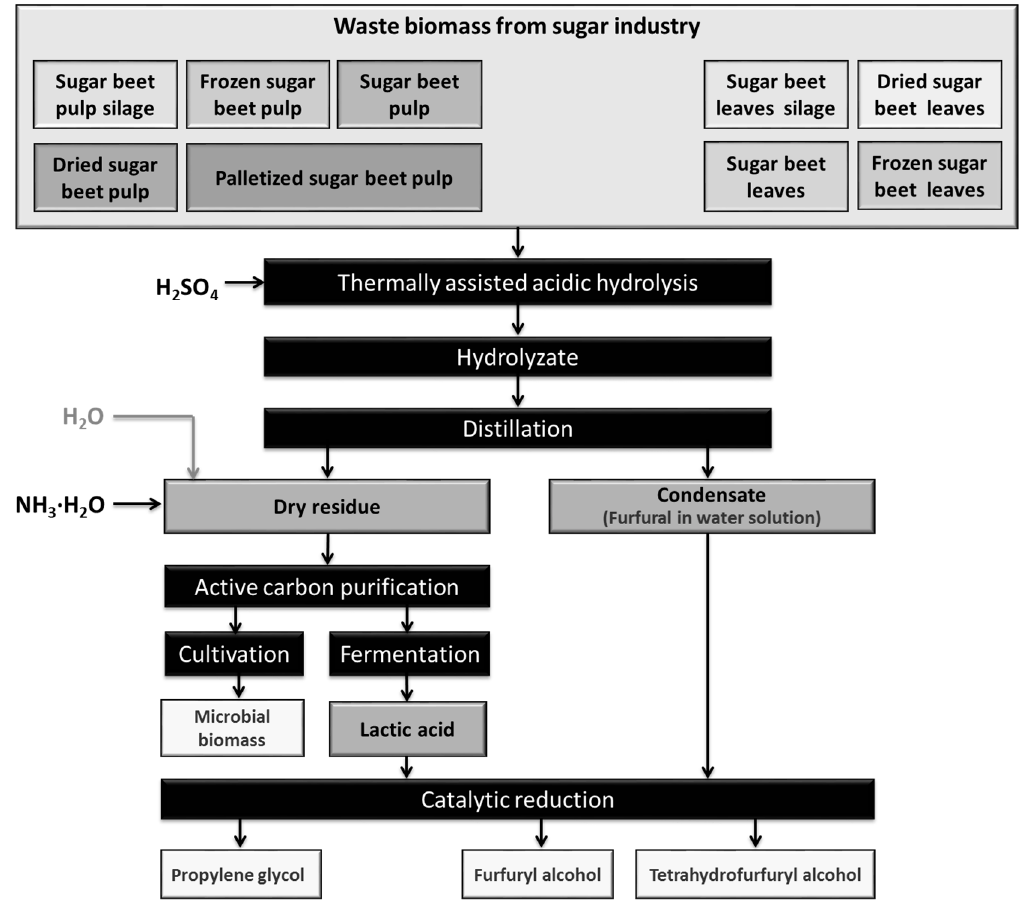
Figure 1. Thermally-assisted acidic hydrolysis of waste biomass with product treatments.